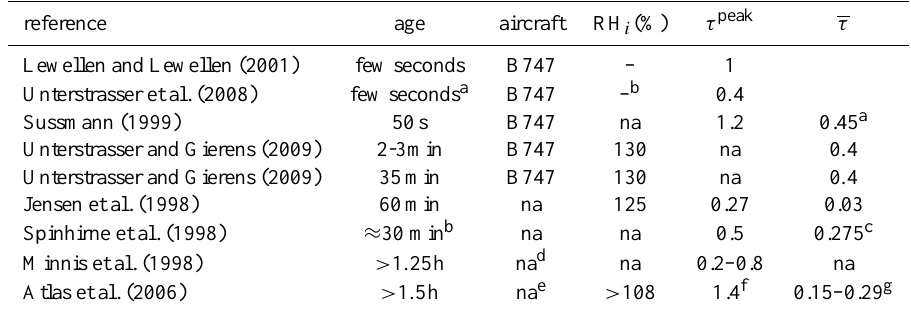
Table 3. Typical optical depth referenced in the literature. The values come from measurements and simulations for different wake ages, different type of aircraft and different ambient conditions.